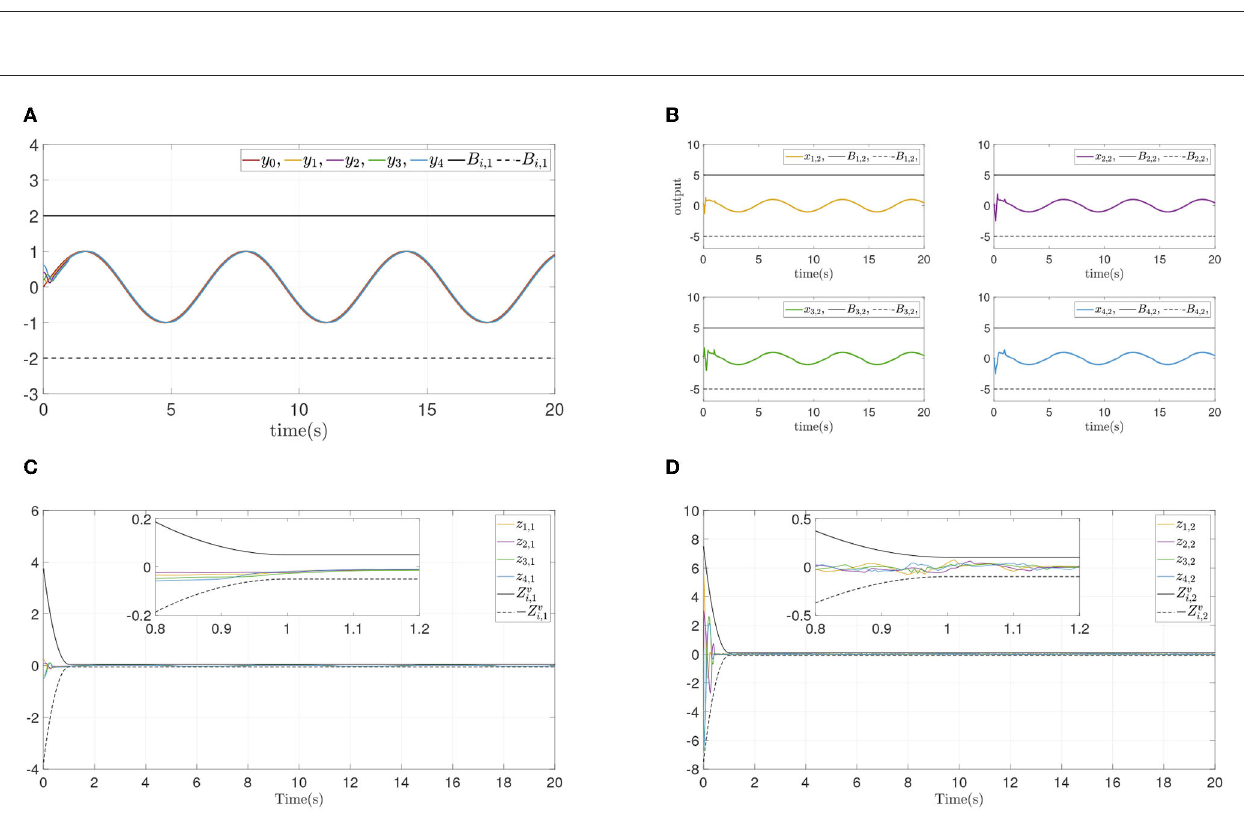
FIGURE8 Simulation results of Example B case III. (A) Followers’ outputs y i . (B) Followers’ states x i ,2 . (C) Synchronization error z i ,1 . (D) Dynamics error z i ,2